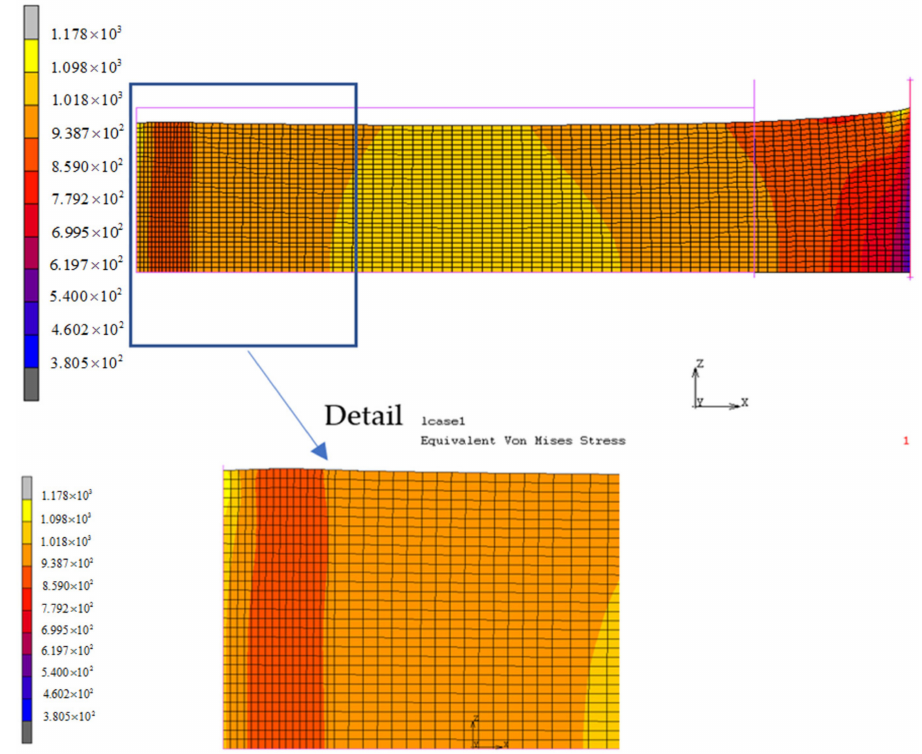
Figure 18. FEM Von Mises stresses distribution at the specimen.